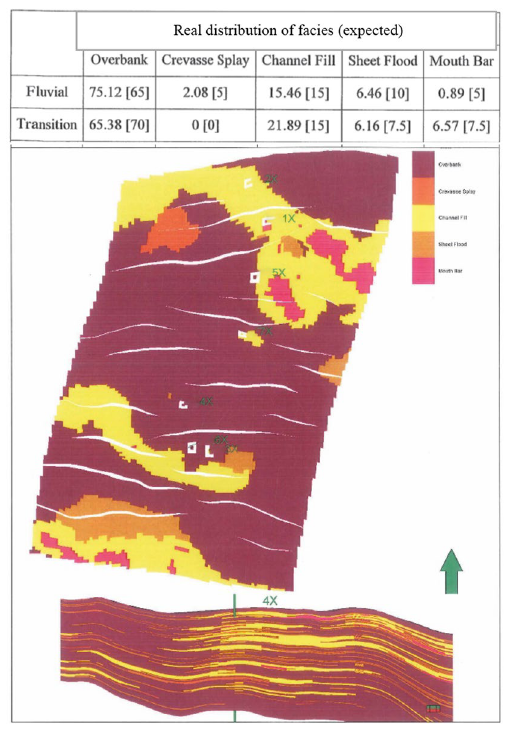
Fig. 28 Resulting model of case R2_2